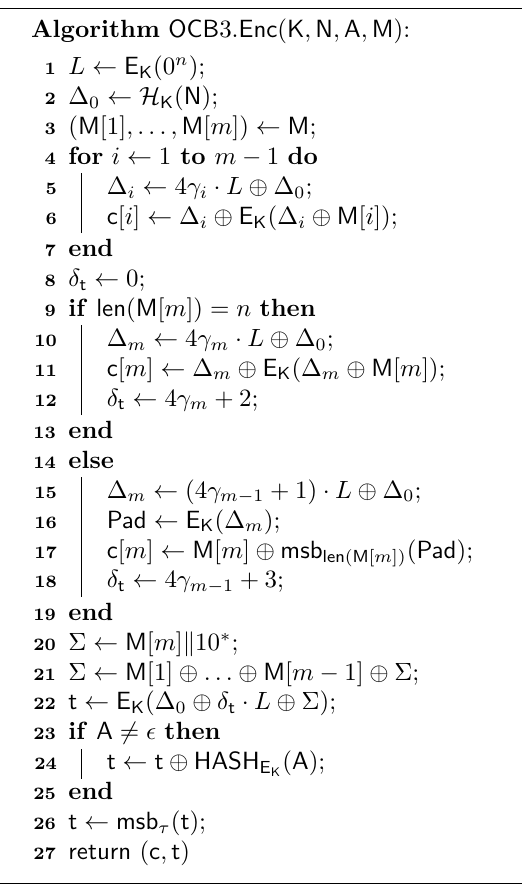
Figure 2: OCB3 block-cipher mode. Here H K is a keyed hash function and HASH E algorithm that processes the associated data A for authentication. The details of H K and HASH E are not relevant for our attack and are therefore K